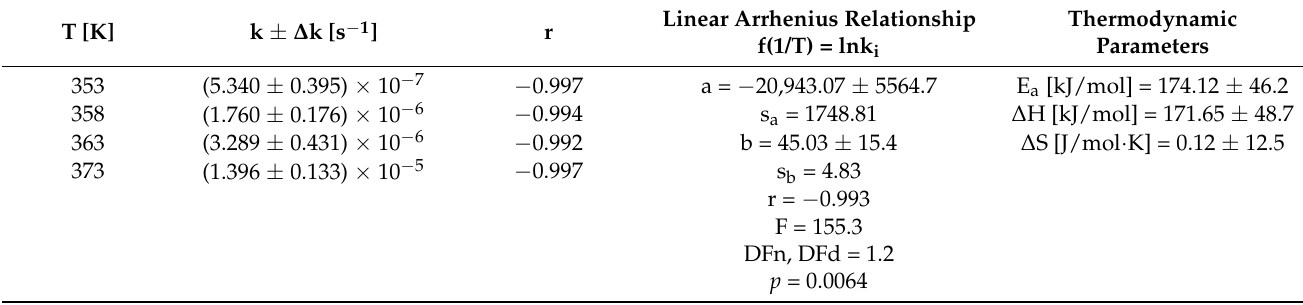
Table 1. Kinetic and thermodynamic parameters of solid state RAM degradation under RH